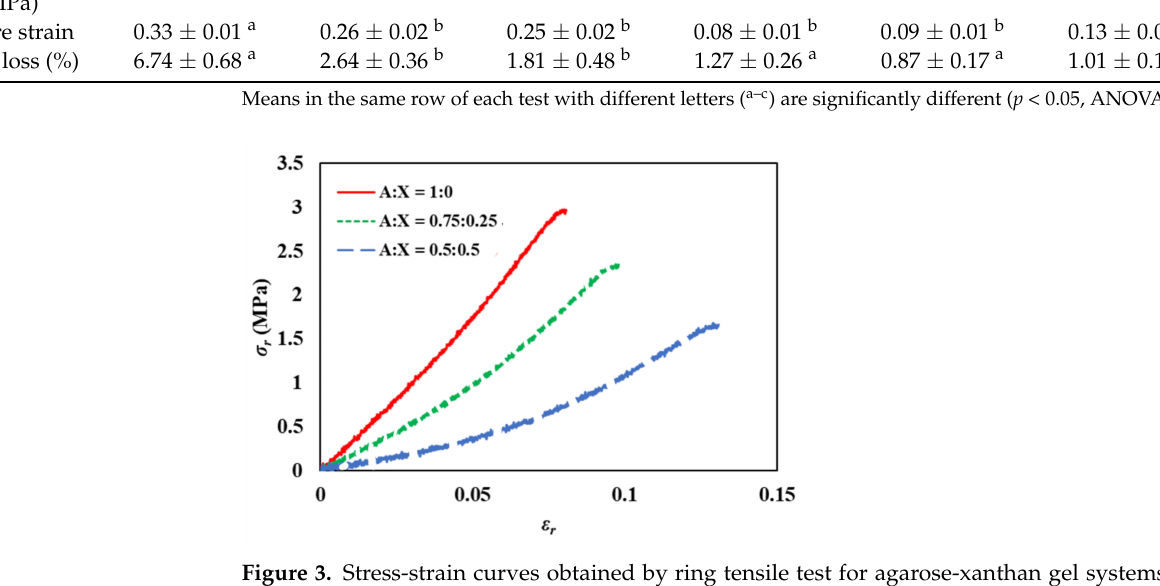
Figure 3. Stress-strain curves obtained by ring tensile test for agarose-xanthan gel systems. A is agarose and X is